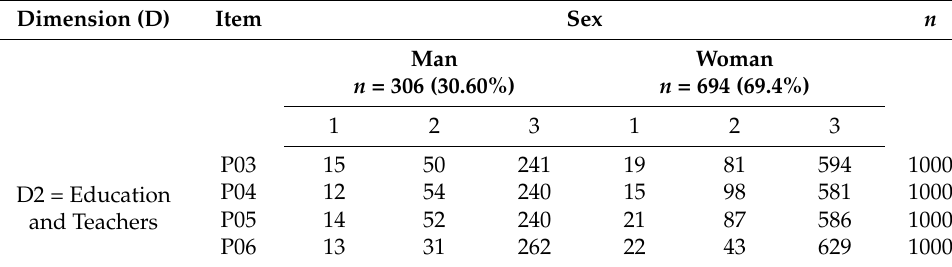
Table 3. Count by Sex of the participating sample for dimension D2.